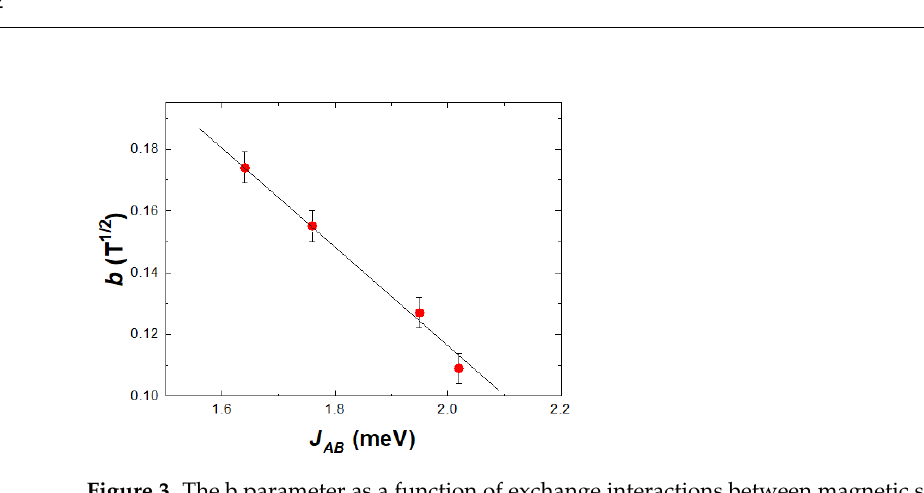
Figure 3. The b parameter as a function of exchange interactions between magnetic sublattices.